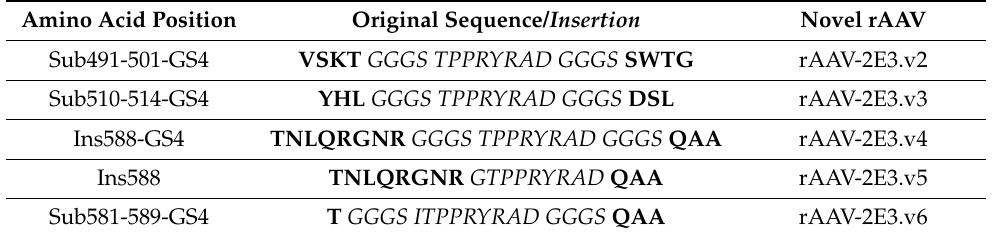
Table 1. Design of novel AAV2 based viral capsids via peptide